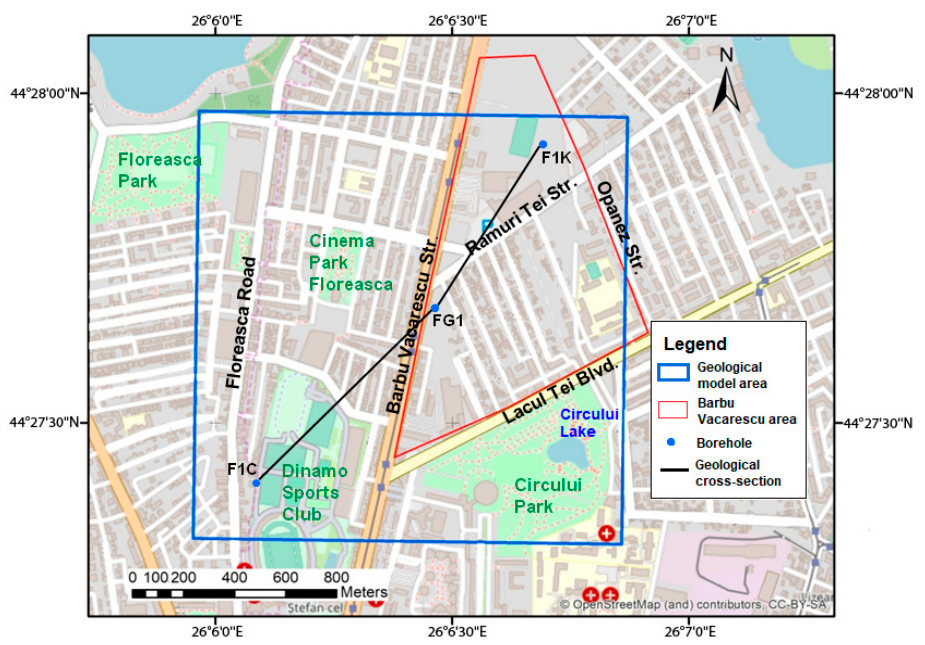
Figure 4. Barbu Vacarescu area. The red limit represents the identified subsidence area in this study. The blue rectangle represents the geological model limits. The black line indicates a geological cross-section presented in the upcoming sections. Map generated in Esri ® ArcMap ™ 10.3. Base map source: OpenStreetMap.